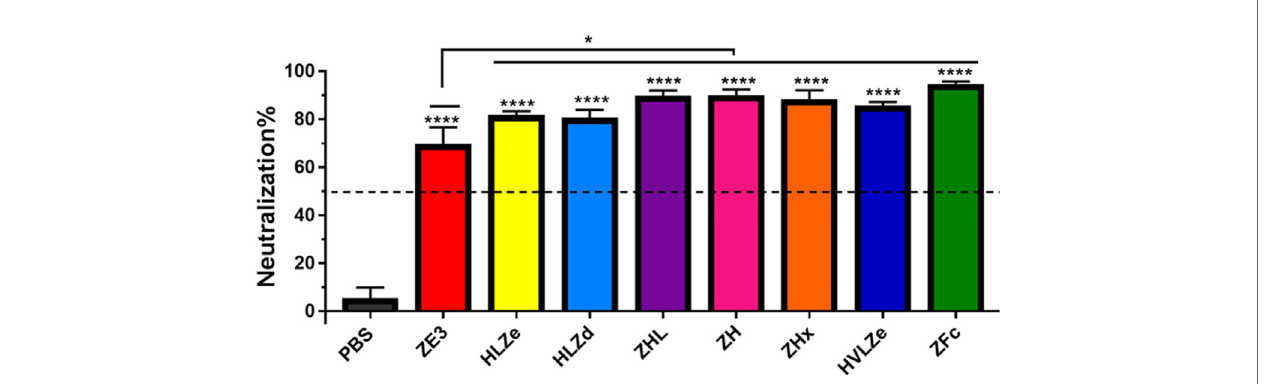
FIGURE 7 | Neutralization of ZIKV. Plaque reduction neutralization assays (PRNT) assays were performed using pooled mouse sera with dilution ratio of 1:10 to evaluate ZIKV-speci fi c neutralizing antibodies in the sera. Data are presented as mean neutralization % and SD from three independent experiments with technical triplicates for each sample. Statistical analyses were performed using one-way ANOVA, p values from comparison between vaccine treatments and PBS were indicated with **** (<0.0001) or from comparison between vaccine treatments and His-tagged ZE3 were indicated with * (p < 0.024).